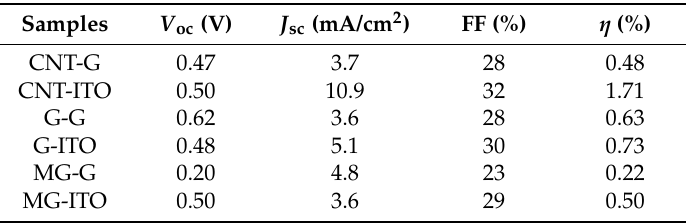
Table 1. Photovoltaic parameters of different solar cell devices.